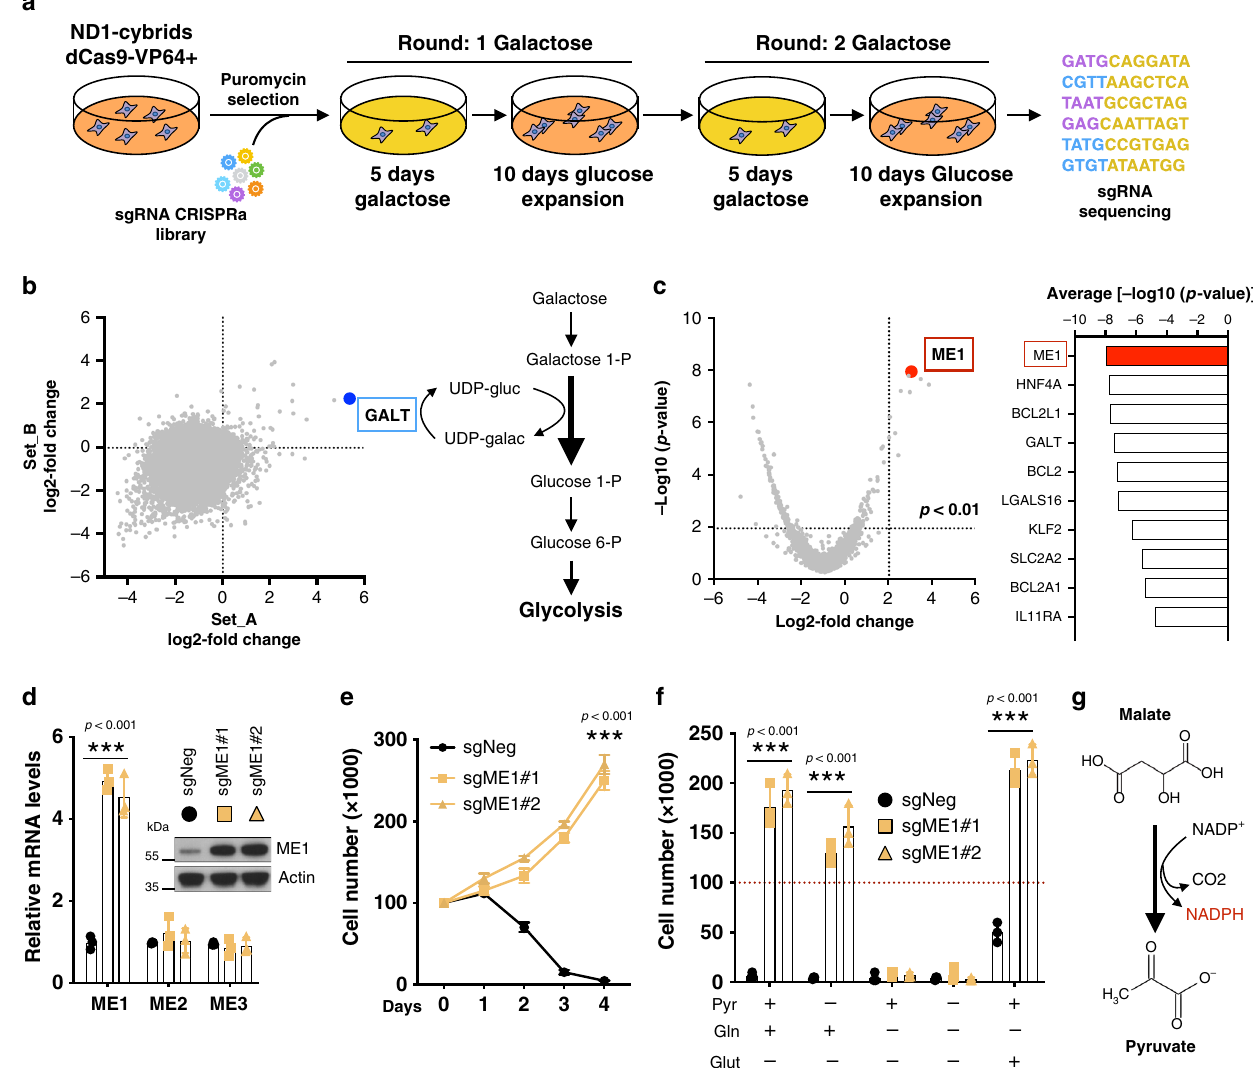
Fig. 1 Identi fi cation of ME1 through a gain-of-function CRISPR/Cas9 screen. a Schematic overview of the genome-wide CRISPR activator screen. b Scatterplot showing gene enrichment after galactose challenge using two independent library replicate sets . Highlighted in blue is GALT gene, which represents the rate-limiting enzyme in galactose-to-glucose conversion. c Volcano plot highlighting ME1 (red dot) as the best scoring gene (left) and the top 10 scoring genes ranked by signi fi cance. d Speci fi c mRNA and protein induction of ME1 using two different guides in ND1 mutant cells ( n = 3). e Cell survival and proliferation curves in ME1-overexpressing ND1 mutant cells under galactose ( n = 3). f Cell survival in ME1-overexpressing ND1 mutant cells cultured under galactose media for 96 h in the presence or absence of glutamine (4 mM), glutamate (4 mM), or pyruvate (1 mM) ( n = 3). g ME1 catalyzes the decarboxylation of malate to pyruvate generating NADPH. Immunoblots shown are representative of >3 independent experiments, and all other experiments are represented as means± SEM., n > 3 biological replicates. Asterisks denote * p < 0.05, ** p < 0.01, or *** p < 0.001. Paired two-tailed Student ’ s t test in d , e and two-way ANOVA in f . Pyr pyruvate, Gln glutamine, Glut glutamate. Red dashed lines indicate initial seeding